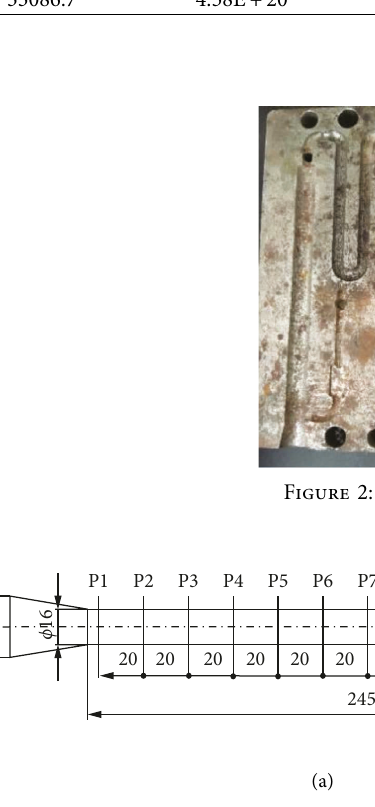
Figure 3: Cross-sectional locations and positions for measurement, (a) cross-sectional locations and (b) positions for measurement.